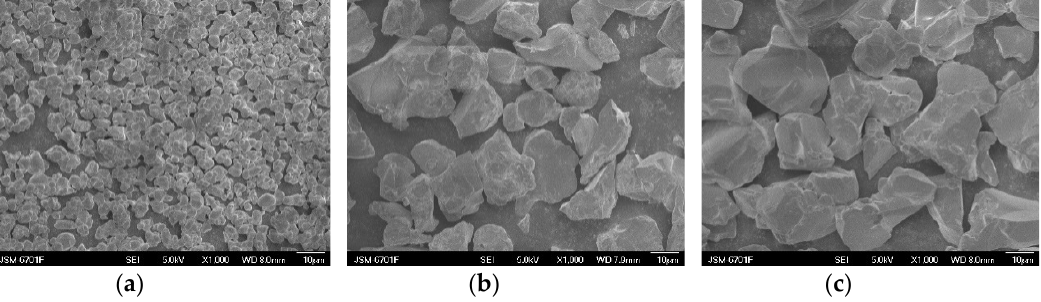
Figure 3. The SEM images of the Lu 3 Ga 2 Al 3 O 12 : Ce 3+ synthesized at ( a ) 1350 °C, ( b ) 1450 °C, and ( c ) 1550 °C for 3 h.